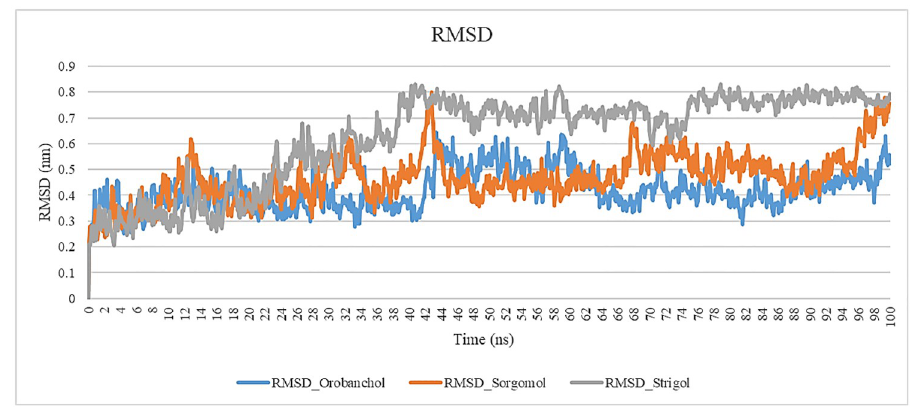
Fig 4. Root mean square deviation (RMSD) of c-alpha for the protein in interaction with Sorgomol, Orobanchol and Strigol during 100 ns